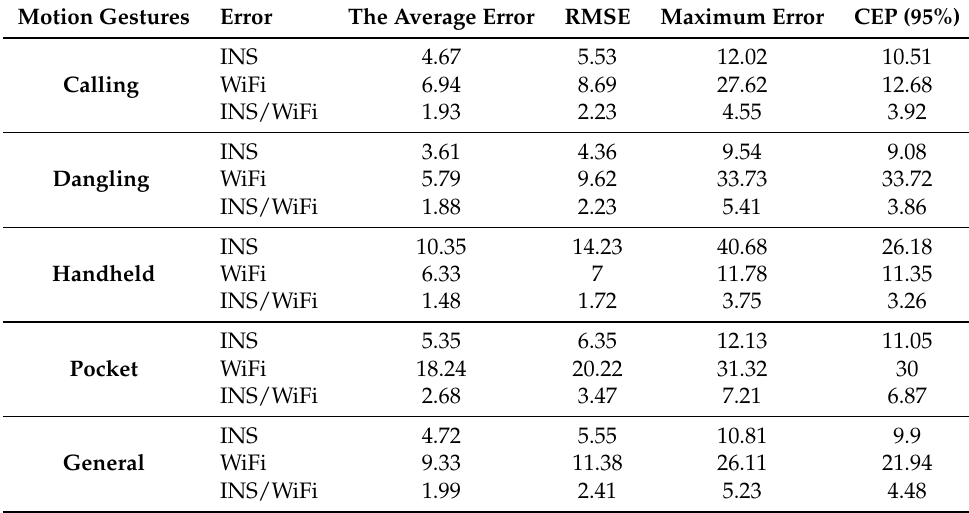
Table 1. Position errors for INS, WiFi and INS/WiFi